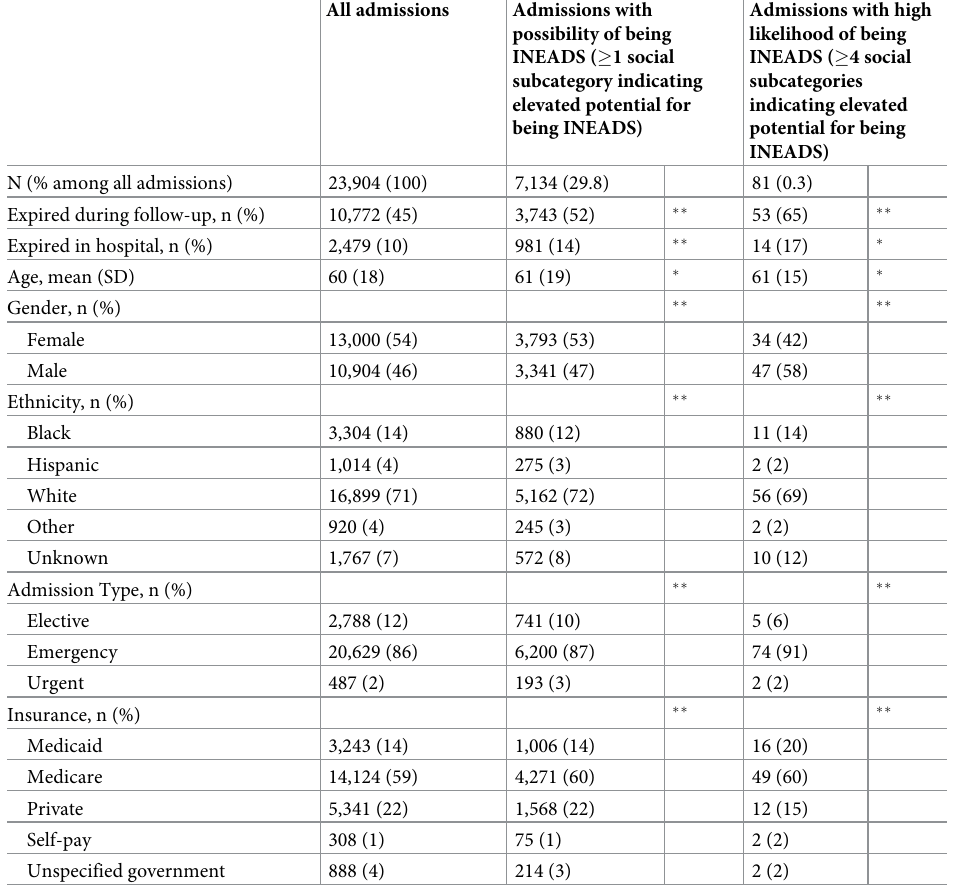
INEADS, Incapacitated with No Evident Advance Directives or